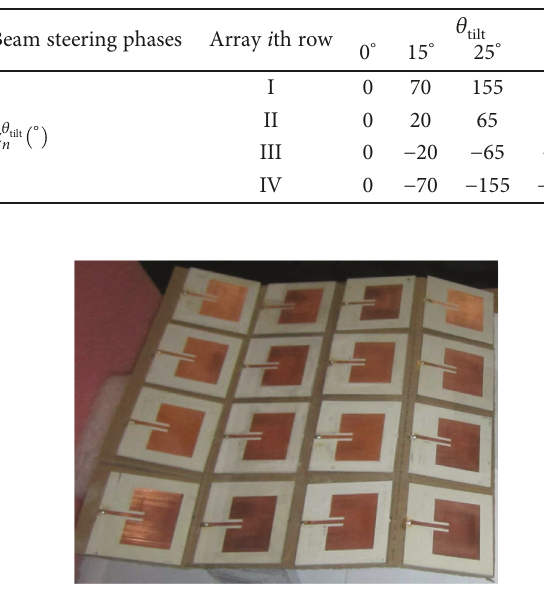
Figure 4: Fabricated 4 × 4 array prototype.